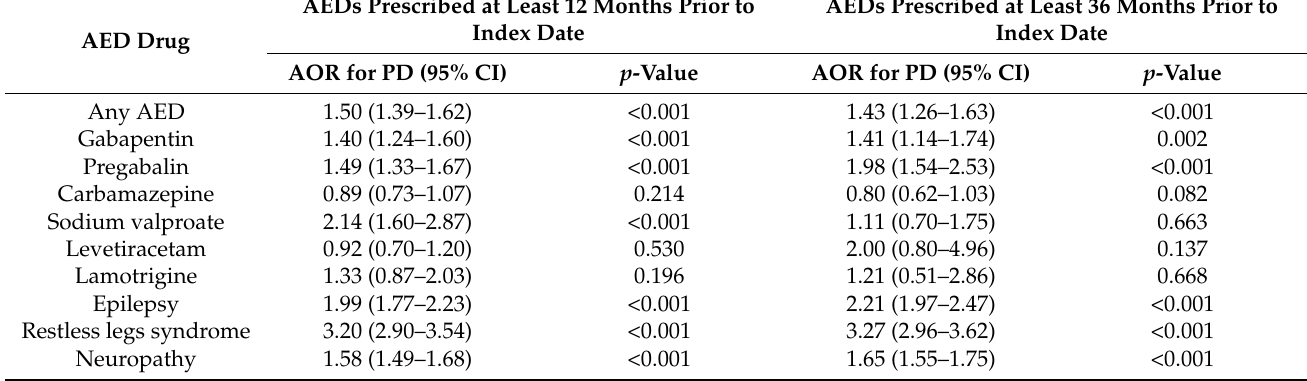
Table 3. Association between antiepileptic drugs prescribed in the past and incident Parkinson’s disease among patients followed in German primary care